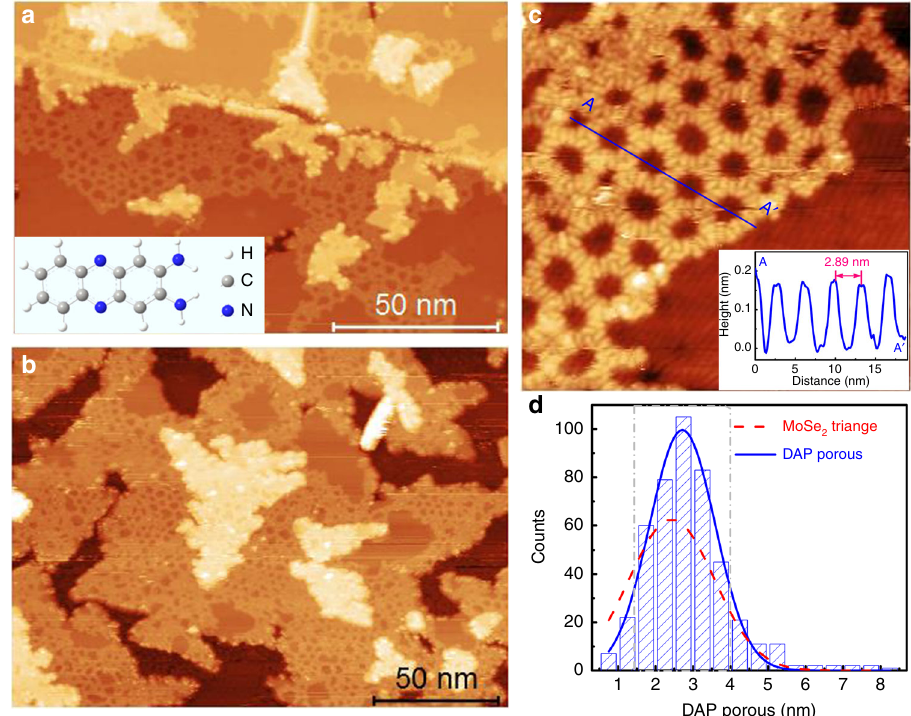
Fig. 3 STM images of the sub-monolayer DAP on MoSe 2 /HOPG. a 0.36 ML and b 0.80 ML DAP molecules assemble on the MoSe 2 surface, forming porous supramolecular structure. (size: a , 180 × 120 nm 2 ; b , 200 × 150 nm 2 ; V S = 2.2 V, I = 86 pA). The inset in panel a is a DAP molecular structure. c An enlarged STM image of the DAP porous network (size: 30 × 30 nm 2 ; V S = 2.75 V, I = 100 pA).The inset is the line-pro fi le corresponding to the blue line in panel c . d Statistical analysis of the DAP porous size over many large-scale images (more than 400 DAP pores). The blue line and the red dash line are the fi tting distribution curves of DAP porous and triangle MoSe 2 domain size, respectively. The grey dash-dot-line shows the main distribution region of